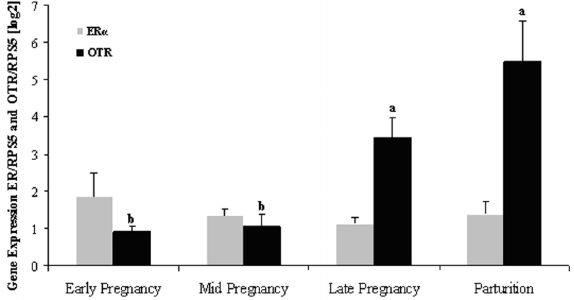
Figure 2. Relative expression of estrogen receptor ( ER a ) and oxytocin receptor ( OTR ) in the myometrium during Early (n=11), Mid (n=12) and Late pregnancy (n=12) and Parturition (n=11). a,b Significantly different among groups (P , 0.05, LSD